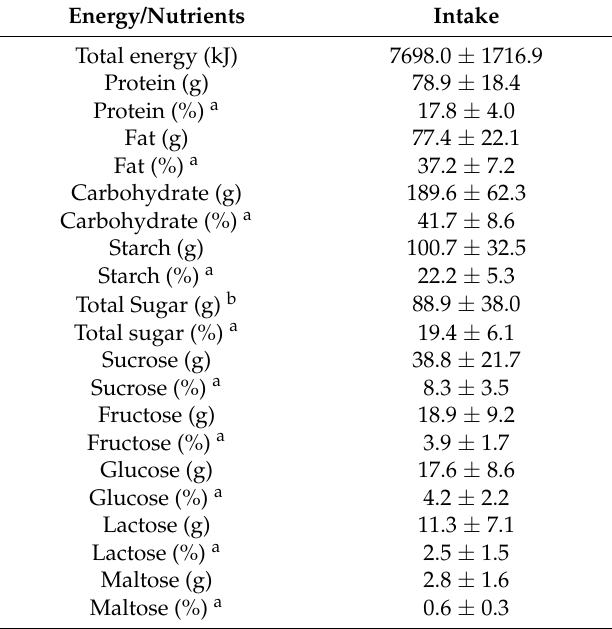
Table 3. Daily intakes of total energy, macronutrients and sugars.